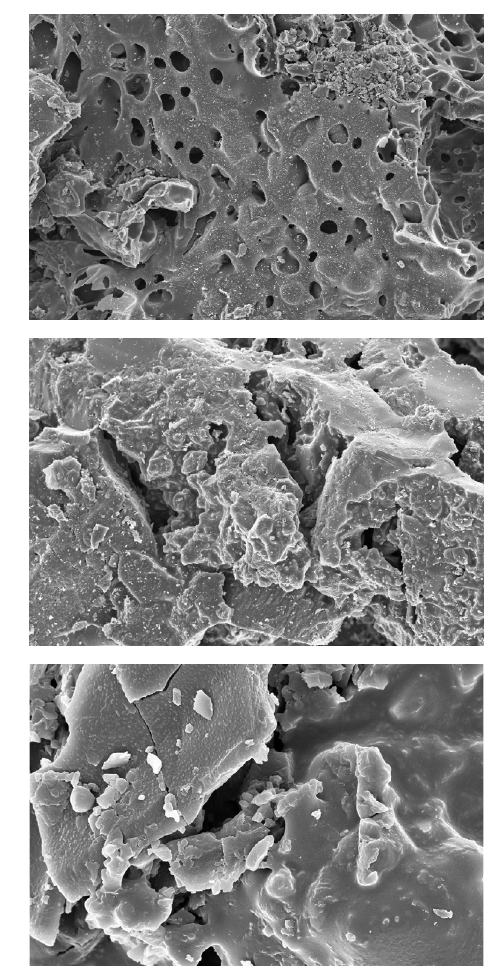
Figure 5: The SEM images of samples (a) A–1, (b) A–2, (c)